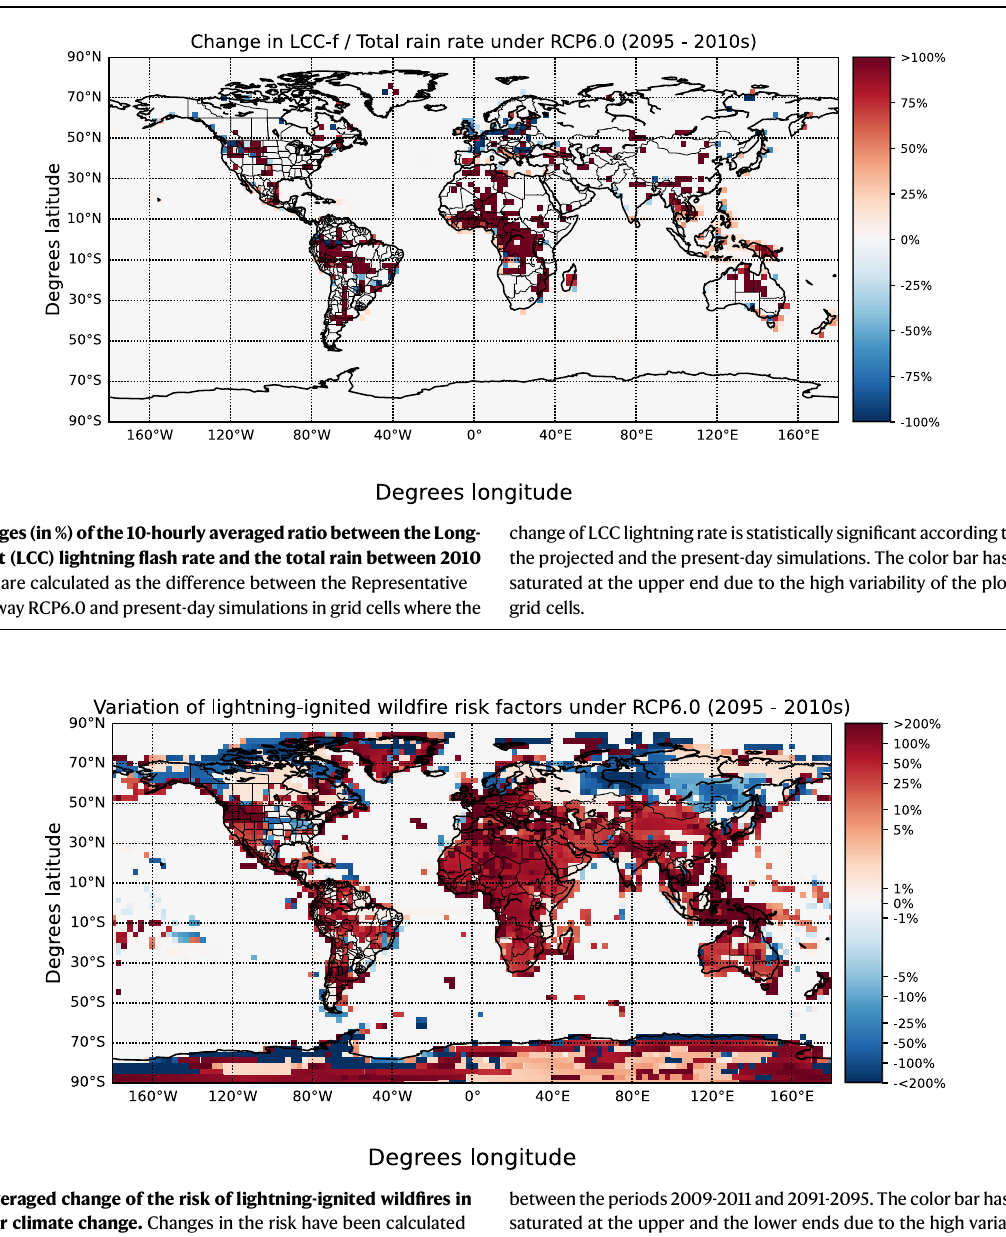
Fig. 4 | Annually averaged change of the risk of lightning-ignited wild fi res in each grid cell under climate change. Changes in the risk have been calculated from the variation of total lightning, Long-Continuing-Current (LCC) lightning, vapor pressure de fi cit, temperature, total rain and relative humidity over ocean